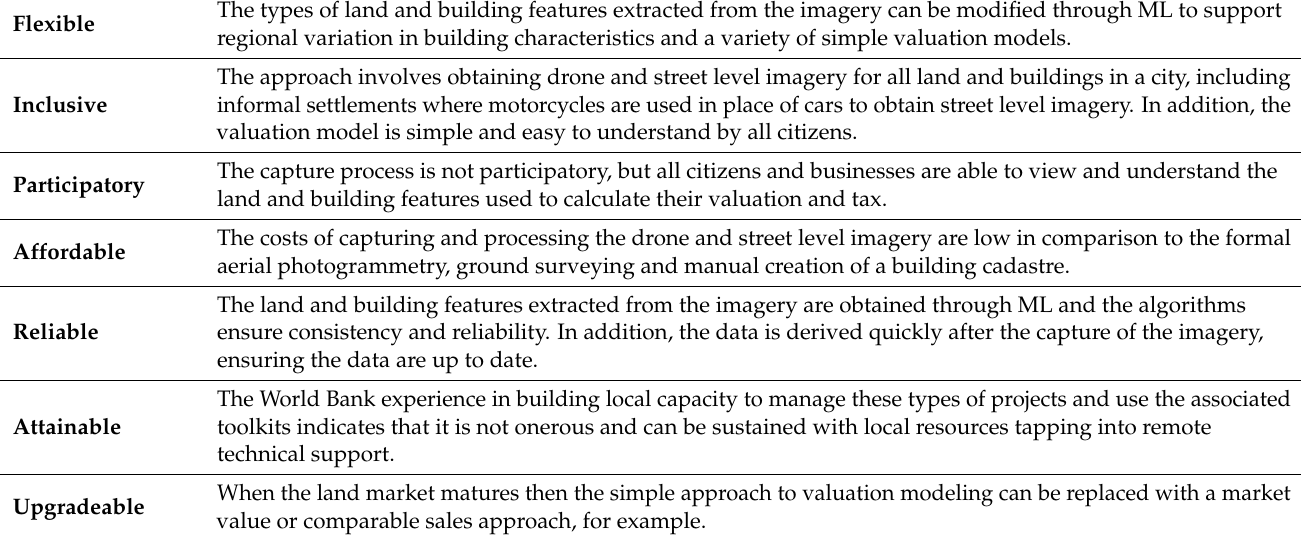
Table 5. FFP Approach Compliance